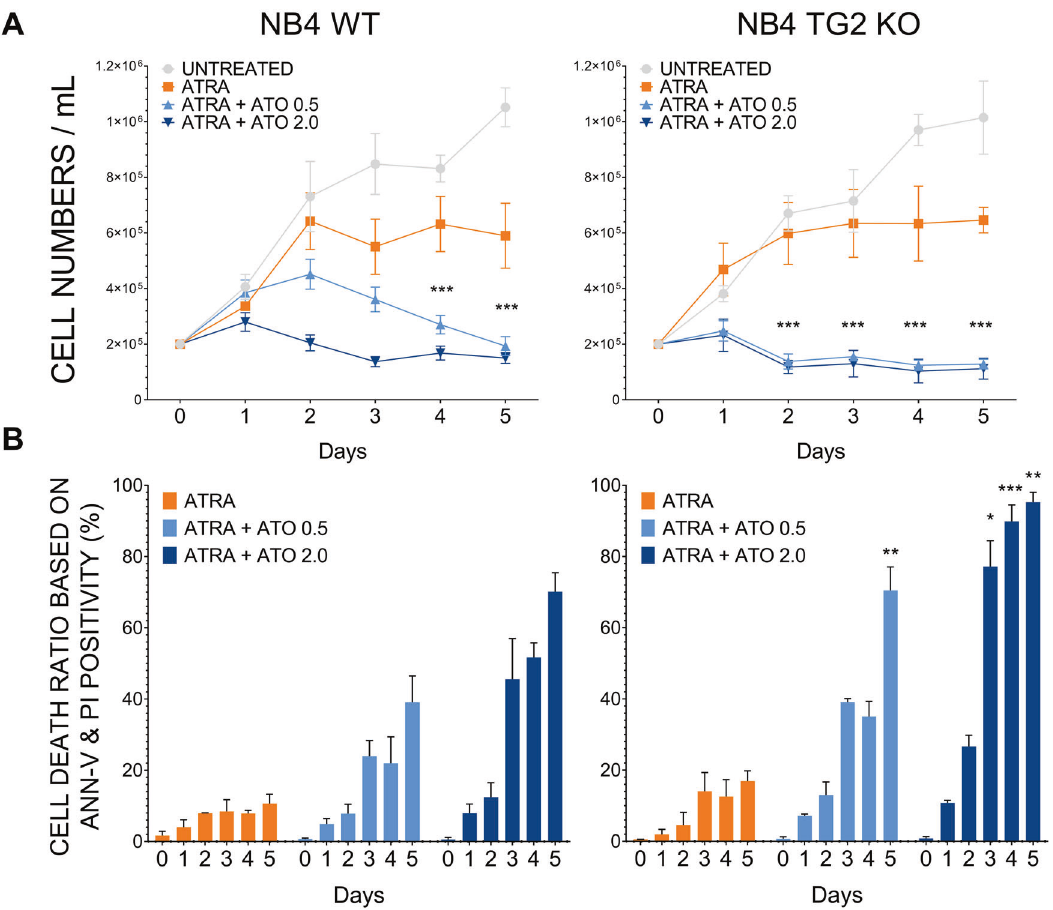
Fig. 1 Transglutaminase 2 lowers ATO-induced cell death. A Cell number changes measured in KOVA Glasstic ® Slide cell number counting chambers following treatment of NB4 WT and NB4 TG2-KO cells without treatment (UNTREATED) or with 1 μ M ATRA; 1 μ M ATRA + 0.5 μ M ATO; and 1 μ M ATRA + 2.0 μ M ATO at the indicated days ( n = 13). Asterisk are representing the signi fi cant differences between the ATRA – ATO treatment versus ATRA treatment. B FACS analysis of Annexin-V and PI stained NB4 cell lines following ATRA or ATRA + ATO treatment. The percentage of cell death ratio is represented as mean % ±SD ( n = 9). Measurements were conducted in triplicates; values were validated by Flowing software 2.5.1. Statistical analysis was conducted by two-way ANOVA (Bonferroni post-hoc test; * p < 0.05, ** p < 0.01 and *** p < 0.001, **** p < 0.0001). Asterisk show the signi fi cant differences in NB4 WT vs. NB4 TG2-KO cell indicate that the activated and non-activated forms of CD11b/ CD18 and CD11c/CD18 receptors remained signi fi cantly lower with the combined treatment than in cells treated with ATRA alone.